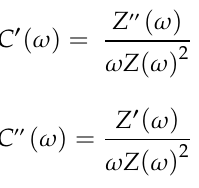
Table S1: Comparison of supercapacitive performance of various supercapacitors (SC) based on MnO x –carbon composites electrodes and reported in literature and in the present